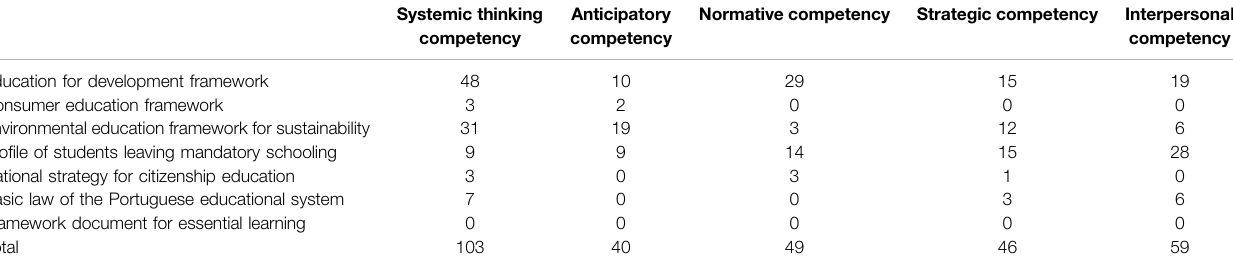
TABLE 4 | Representativeness of competences in the analysis corpus.